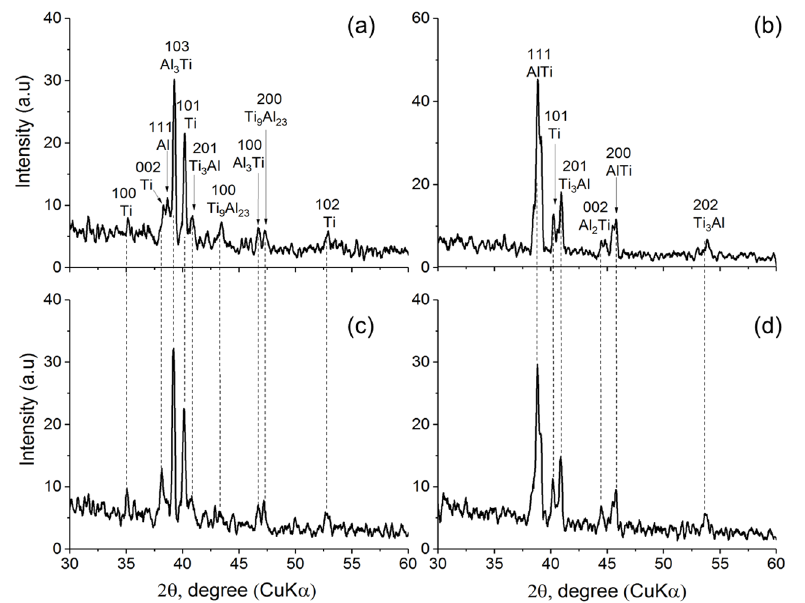
Figure 1. XRD patterns of Ti–Al samples before ( a , b ) and after Si + implantation ( c , d ) after annealing at 600 ◦ C ( a , c ) and 700 ◦ C ( b , d ).